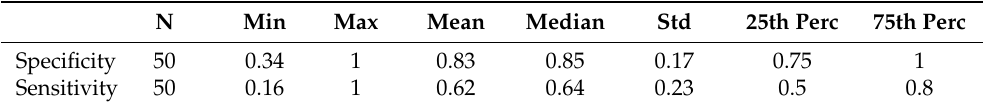
Table 1. Sensitivity and specificity